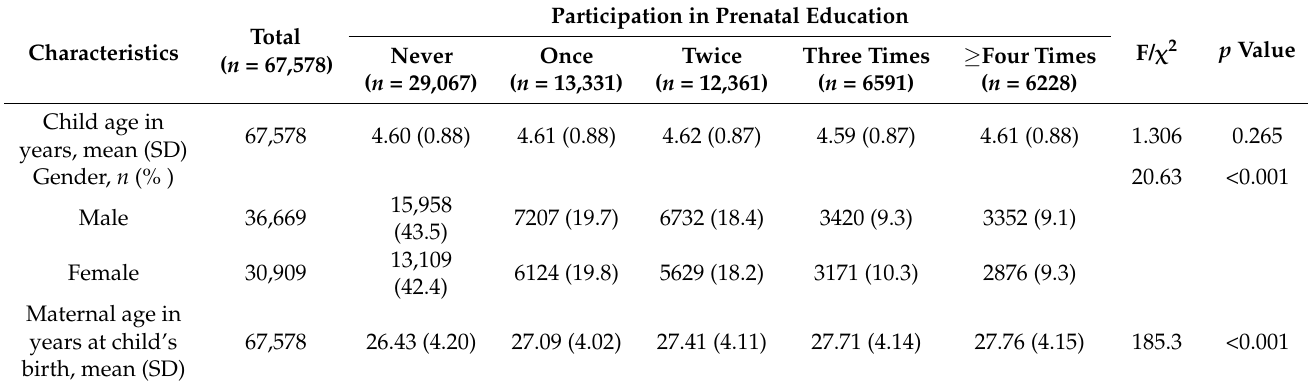
Table 2. Maternal attendances to prenatal education in different socio-demographic characteristics # .